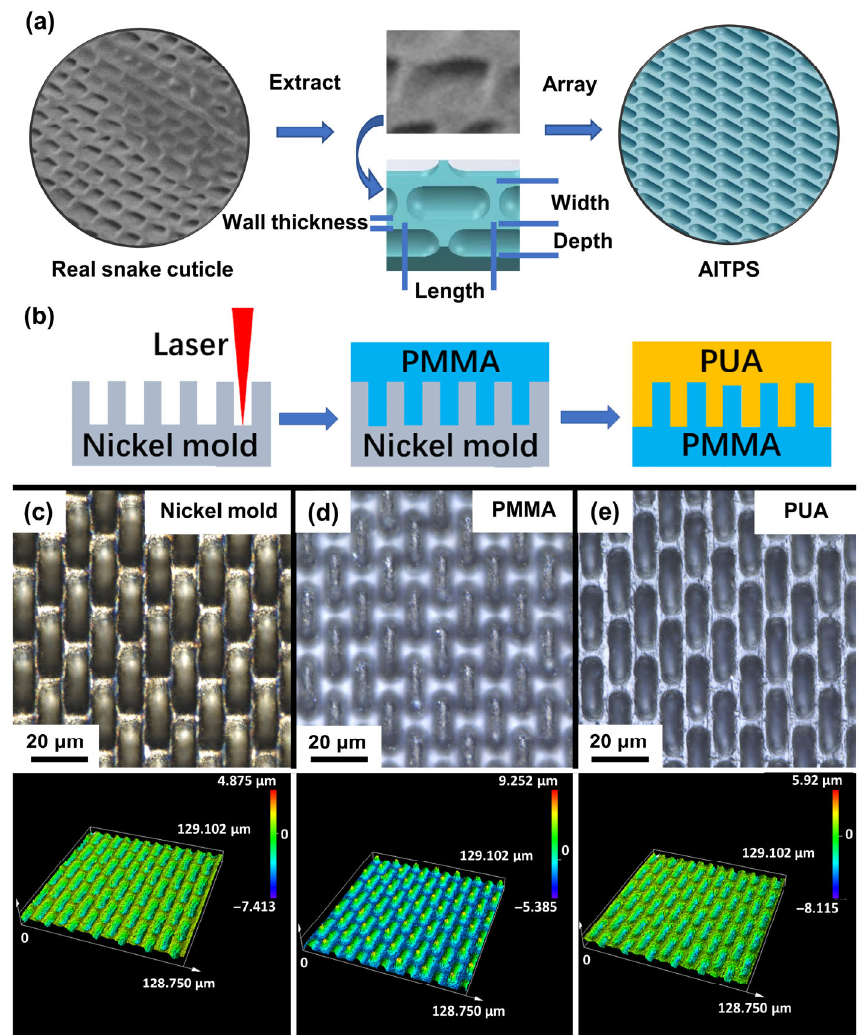
Fig. 2 (a) Schematic description of characteristic (width, length, depth, and wall thickness) extraction of real snake cuticle on biomimetic surface; (b) detailed manufacturing process of picosecond laser manufacturing and two-step replica molding technique; and (c–e) LEXT images of nickel positive mold, polymethyl methacrylate negative mold, and AITPS. Note: PMMA is the abbreviation of polymethyl